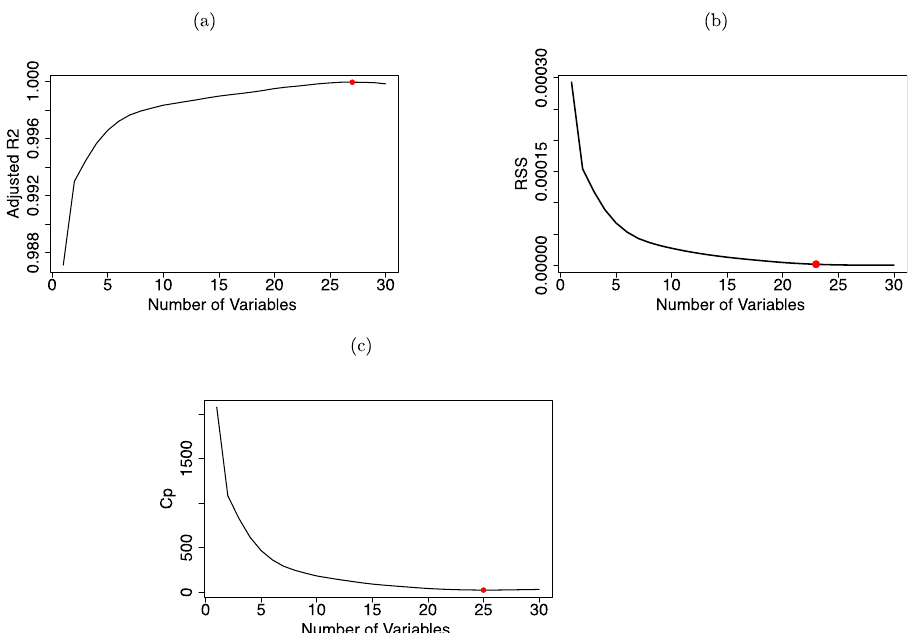
Fig. 5 Criterion to determine optimal number of variables k for the best model. a Adjusted R 2 values for different values of k . b Residual sum of squares (RSS) values for different values of k . c C p values for different values of k